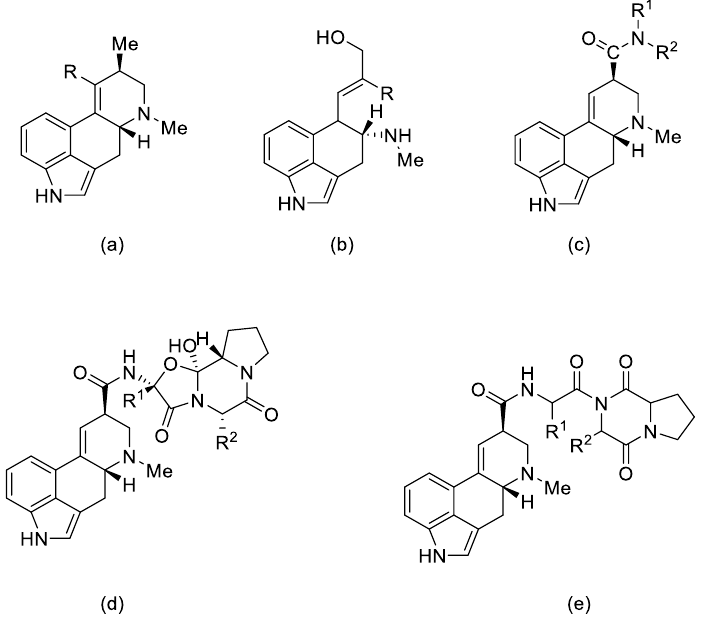
Figure 2. Structural formulas of the 5 main groups of ergot alkaloids: ( a ) clavine alkaloids and ( b ) 6,7-secoergolenes (alkaloids with an open D ring), ( c ) lysergic acid derivatives, ( d ) peptide alka- loids, and ( e ) lactam ergot alkaloids.